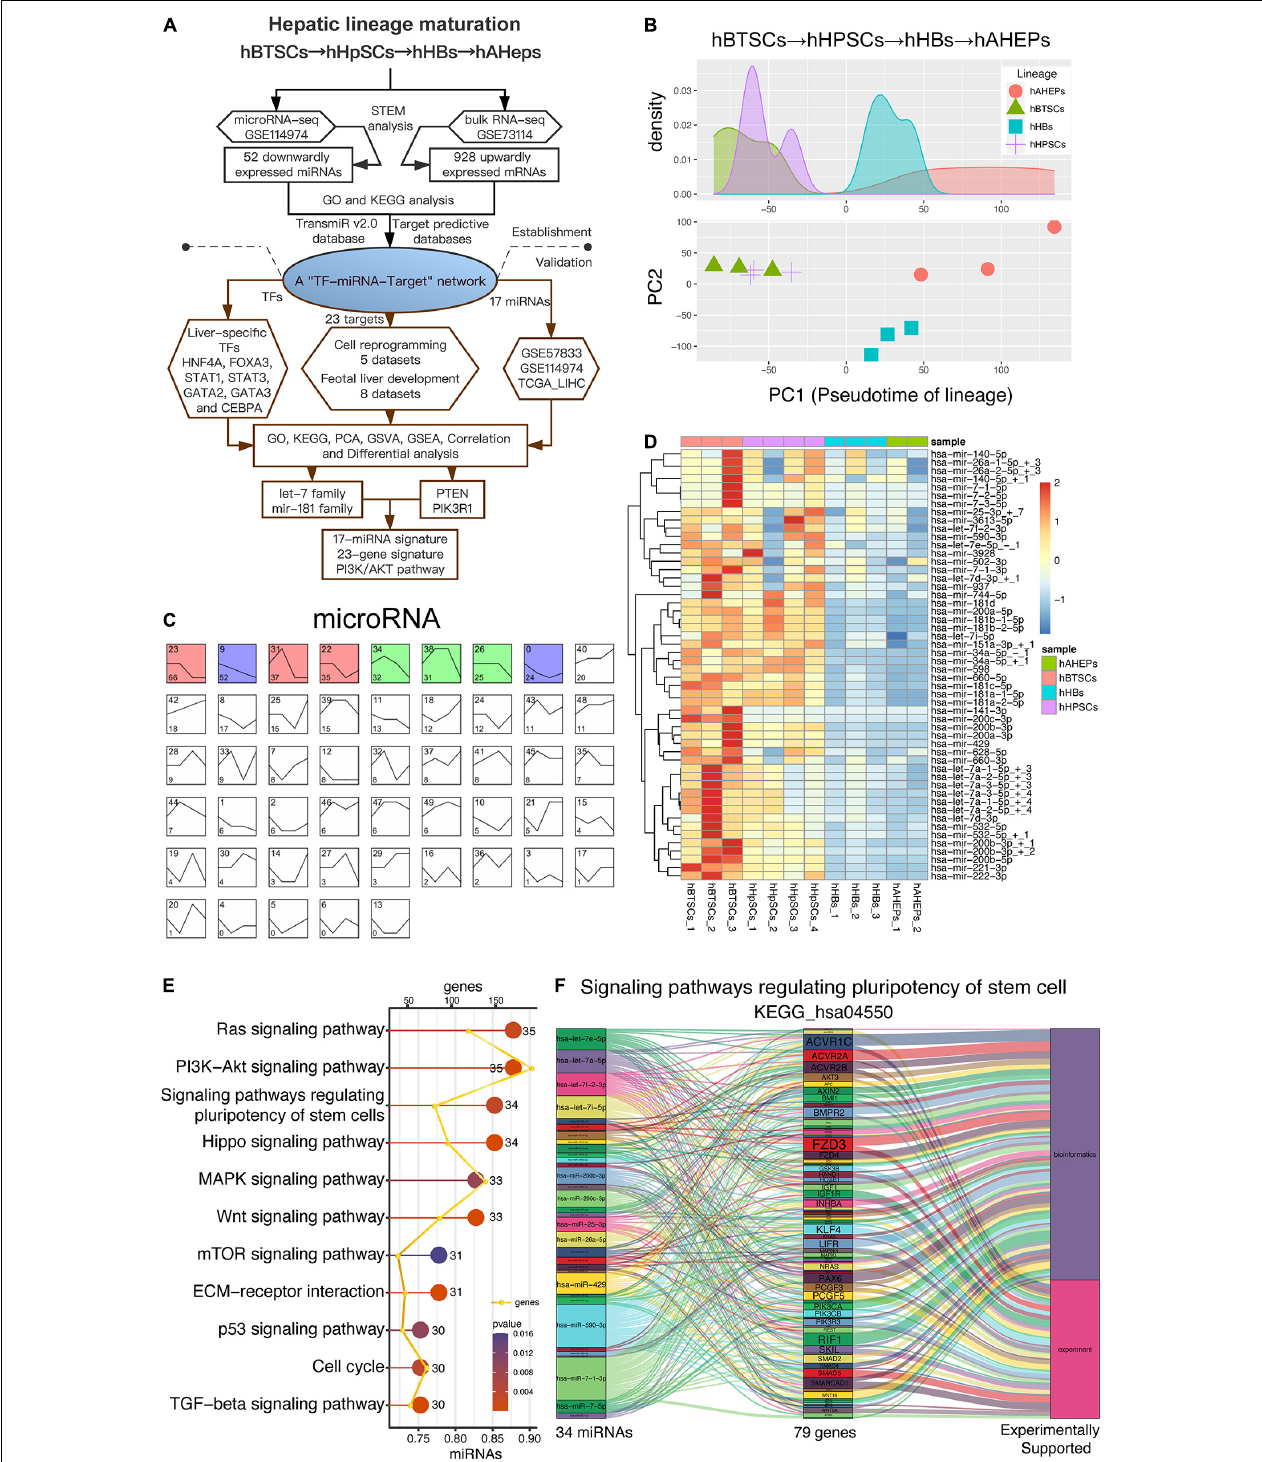
FIGURE 1 | Downwardly expressed miRNAs during hBTSCs differentiation. (A) Flowchart of this study. (B) PCA analysis of four hepatic stages. (C) STEM analysis of the microRNA-seq data. Significant profiles are colored, and the same color represents a similar expression pattern. The top left number of each grid is the profile name while the bottom left number is the total significant genes included in this profile. (D) Heatmap of 52 miRNAs which are gradually downregulated from hBTSCs to hAHeps. (E) KEGG enrichment analysis of 52 miRNAs performed by the DIANA-miRPath v3.0 online database (http://snf-515788.vm.okeanos.grnet.gr). (F) The miRNA-target relationship in the signaling pathway KEGG_hsa04550, termed as the “Signaling pathways regulating pluripotency of stem cell.”